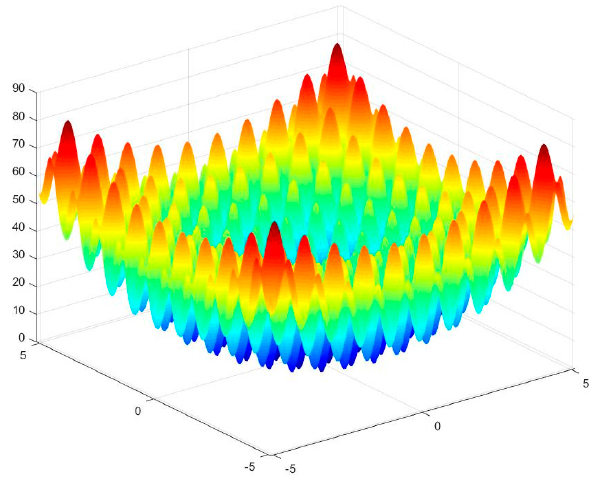
Figure 5. Three-dimensional image of Rastrigin function ( f 3 ).